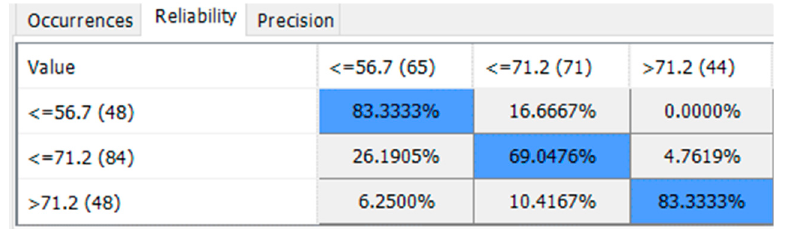
Figure 8. Confusion matrix of occurrences.